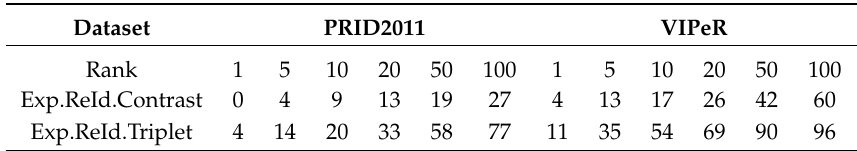
Table 5. CMC scores (%) of the Appearance Affinity model trained with the Double-Margin-Contrastive loss and the Triplet loss on PRID2011 and VIPeR